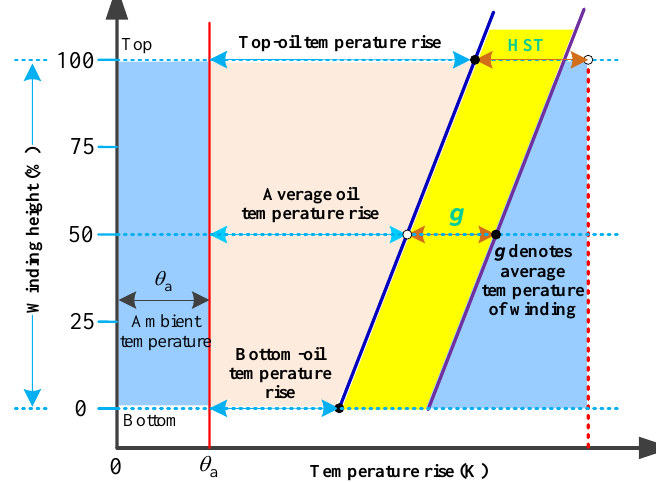
Figure 1. Internal temperature characteristic curve of oil-immersed transformer. HST: hot spot temperature.